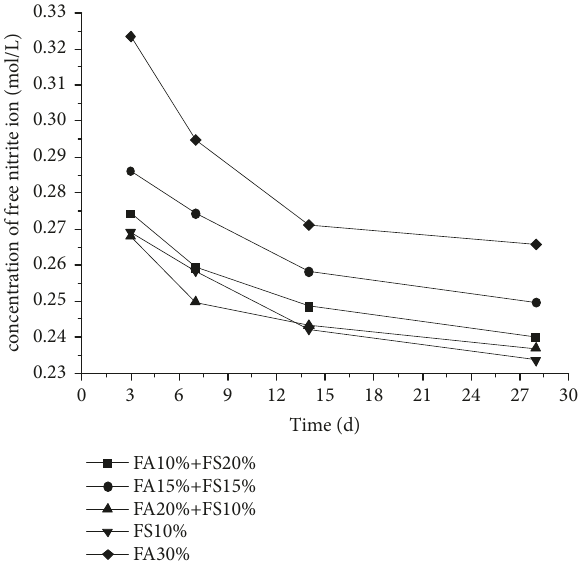
Figure 6: The free nitrite ion concentration of specimens A3, B1, and C1-C3.